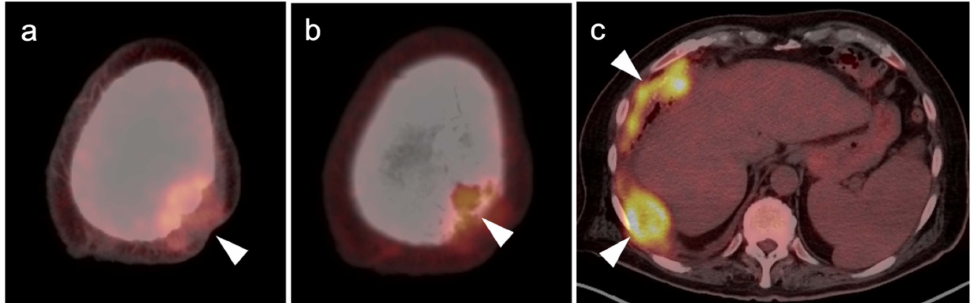
Figure 13. Cutaneous squamous cell carcinoma, metastatic. ( a ) Axial FDG PET-CT of the skull vertex shows a hypermetabolic soft tissue squamous cell carcinoma (white arrowhead) projecting over the skull. ( b ) Axial FDG PET-CT of the skull vertex with bone windows demonstrates destruction of the calvarium (white arrowhead) under the mass. MRI would be needed to evaluate for intracranial extension. ( c ) Axial FDG PET-CT of the upper abdomen shows extensive hypermetabolic right pleural metastases (white arrowheads).